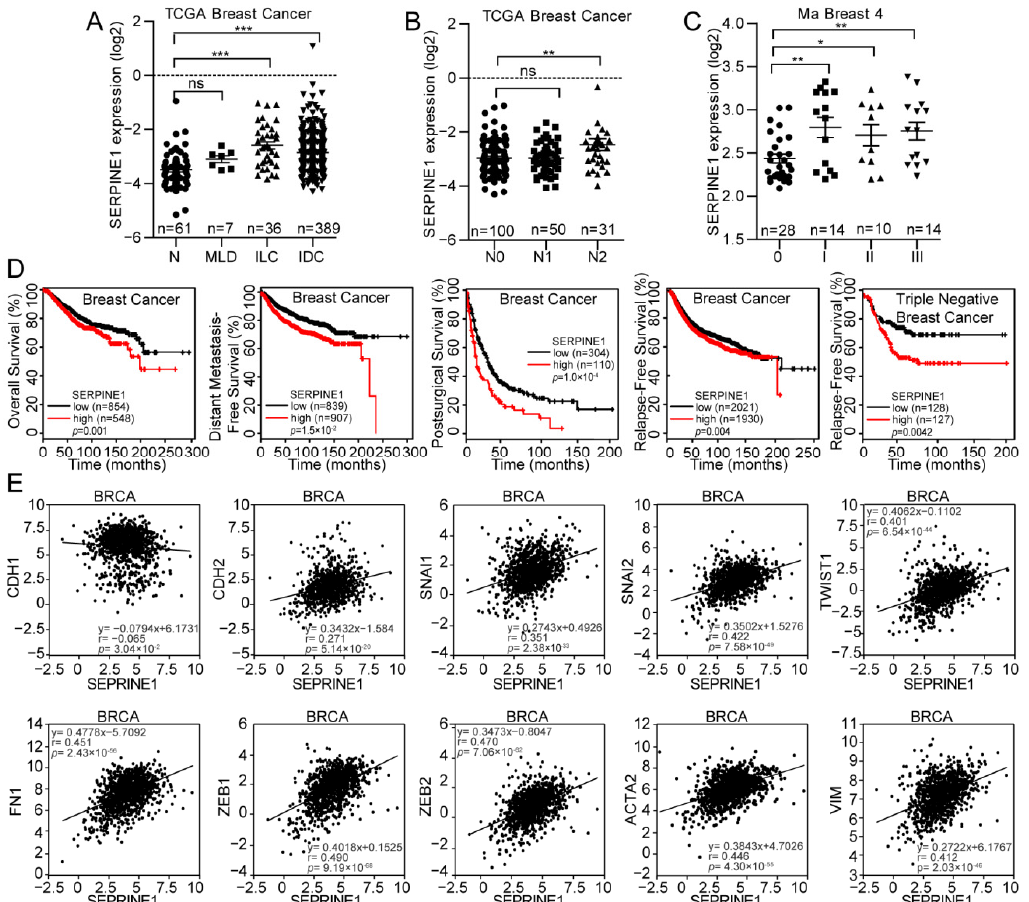
Figure 3. Clinical significance of PAI-1 in patients with breast cancer. ( A ) In accordance with data from the TCGA dataset, PAI-1 in invasive lobular breast carcinoma (ILC) and invasive ductal breast cancer (IDC) was significantly elevated compared with that in normal tissues (N), while no significant difference observed between mix lobular and ductal breast cancer (MLD) and normal tissues. ( B ) PAI-1 is more highly expressed in patients with grade N2 breast cancer than in patients with grade N0 breast cancer. ( C ) PAI-1 in advanced breast cancer was increased compared with that in early breast cancer based on data obtained from Oncomine. ( D ) High PAI-1 expression predicted short distant metastasis-free survival, overall survival (OS), and relapse-free survival (RFS) by the analysis of data from the KM plotter. ( E ) PAI-1 is tightly associated with mesenchymal features in breast cancer, as confirmed by a significantly positive correlation between PAI-1 and mesenchymal markers, including Snail (SNAI1), TCF8 (ZEB1), N-cadherin (CDH2), Twist (TWIST1), Vimentin (VIM), Fibronectin (FN1), Slug (SNAI2) and SIP-1 (ZEB2), while a negative correlation was observed between PAI-1 and E-cadherin (CDH1). * p < 0.05, ** p < 0.01, *** p < 0.001, ns: no significance.